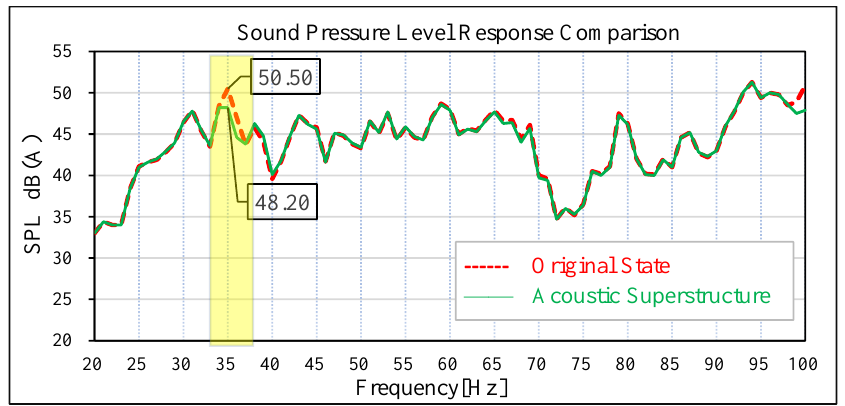
Figure 20. Comparison of sound pressure levels in the middle of rear passenger row.